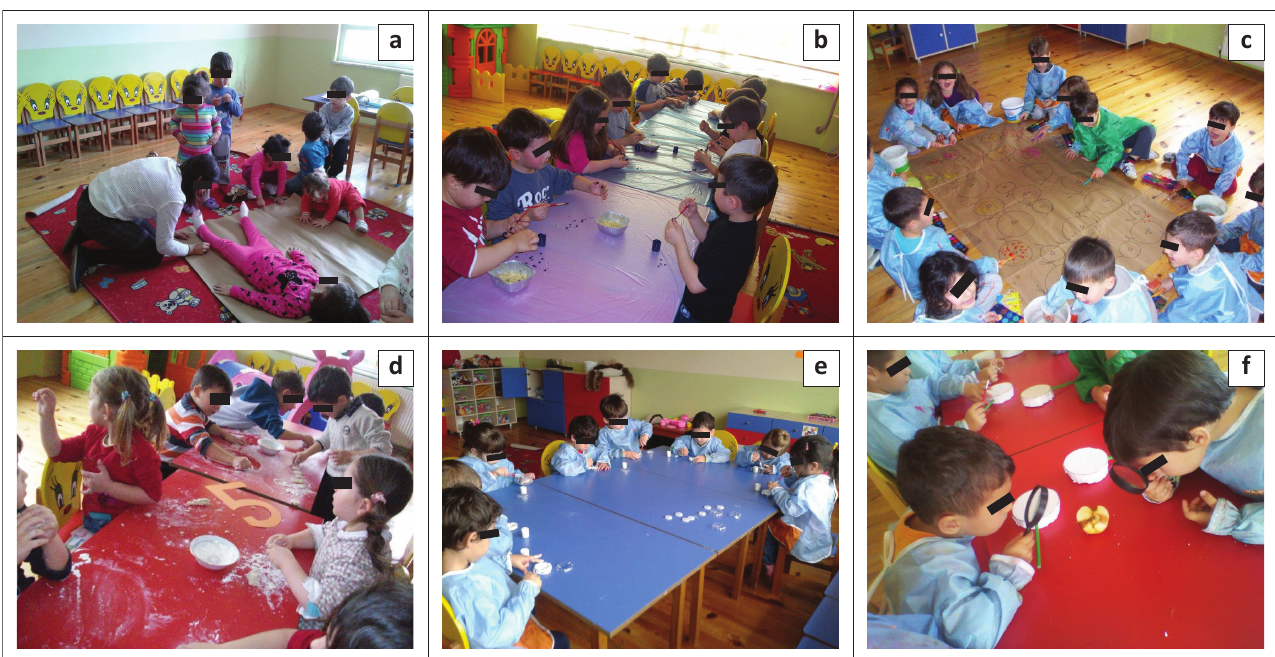
FIGURE 1: Some sections from the kneading and paper or collage works of the modular art education programme applied to